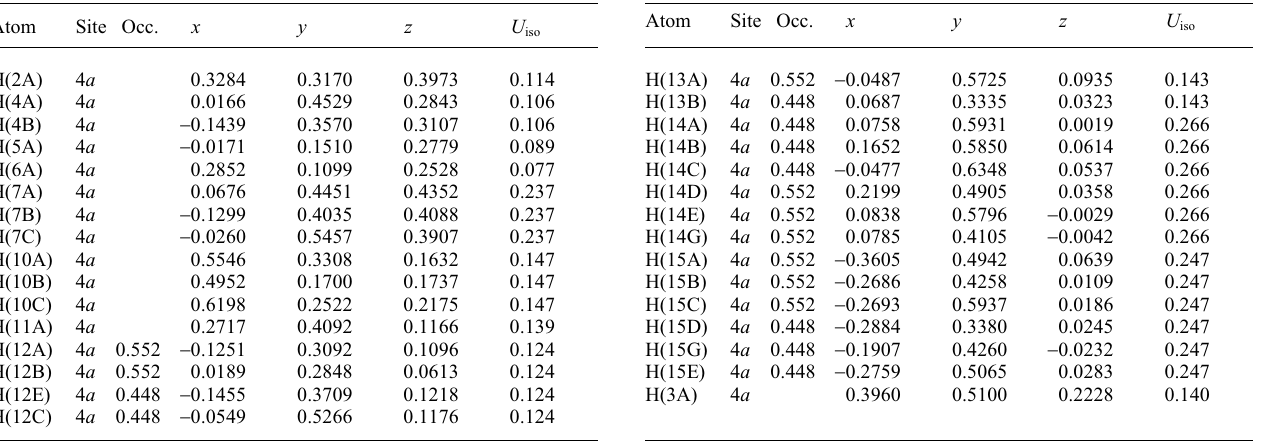
Table 2. Atomic coordinates and displacement parameters (in Å 2 )